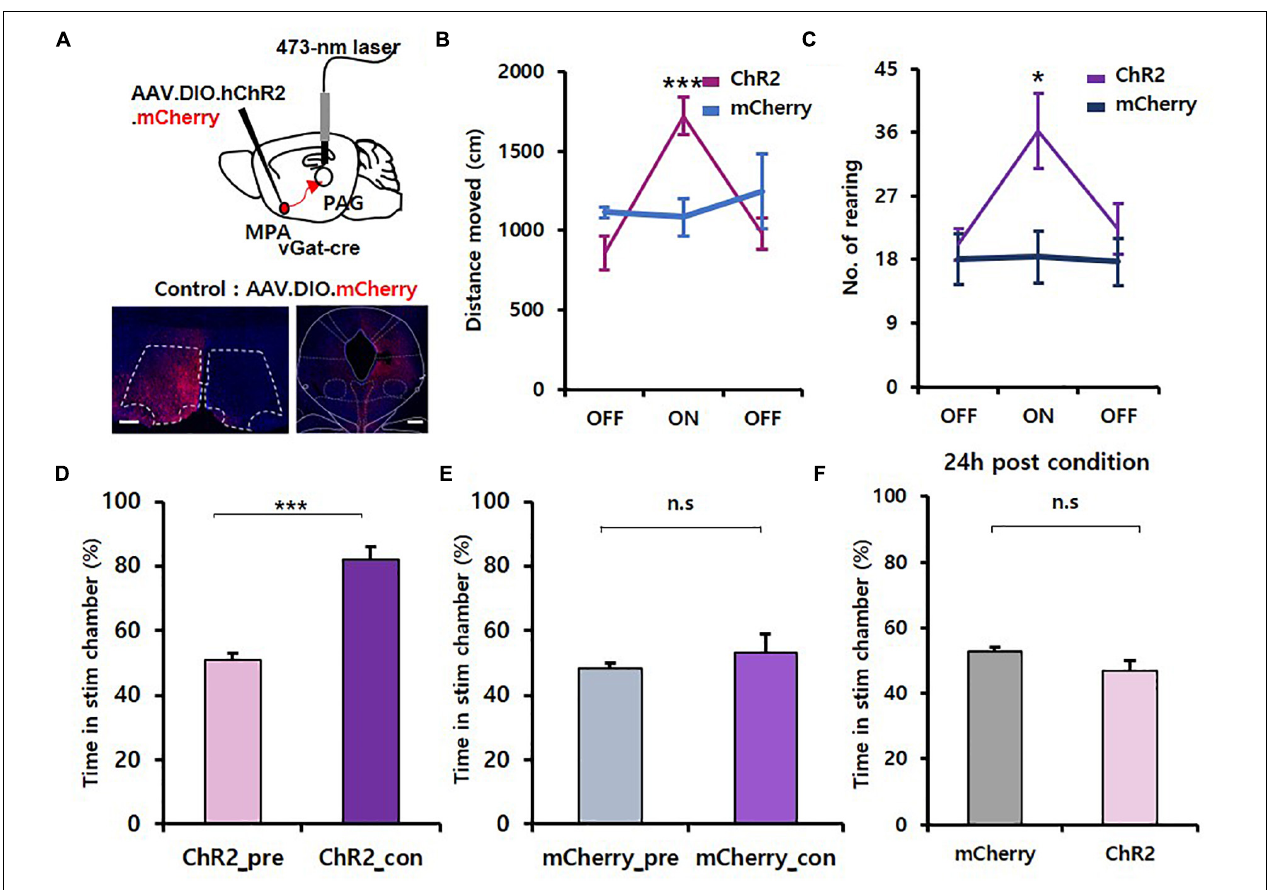
FIGURE 3 | Activation of the MPA vgat –vPAG circuit induces exploration without encoding value. (A) Top, MPA–vPAG circuit photostimulation. Viruses were injected into the MPA, and fiber-optic cannulas were implanted over the vPAG. Bottom, virally mediated expression of ChR2 in MPA neurons of vgat -ires- Cre mice and axon termini in the vPAG. Scale bar, 250 µ m. (B) Photoactivation of MPA vgat neuron axon termini causes increased movement in ChR2-expressing mice ( n = 7; n = 4 males; n = 3 females) compared to mCherry control mice ( n = 3; n = 1 male; n = 2 females); *** p < 0.001. Error bars represent SD. (C) Number of rearing significantly increases in ChR2-expressing mice ( n = 7; n = 4 male; n = 3 females) compared to mCherry control mice ( n = 3; n = 1 male; n = 2 females); * p < 0.05. Error bars represent SD. (D) ChR2-expressing ( n = 7; n = 4 males; n = 3 females) mice show more time in the stimulation chamber during the conditioning session compared to the pretest session; *** p < 0.001. Error bars represent SD. (E) mCherry control ( n = 3; n = 1 male; n = 2 females) do not show real-time preference toward the stim chamber; p = 0.562. Error bars represent SD. (F) Testing for conditioned place preference 24 h after the conditioning session. mCherry control ( n = 3; n = 1 male; n = 2 females) and ChR2-expressing ( n = 7; n = 4 males; n = 3 females) mice do not show preference toward the stim chamber; p = 0.270. Error bars represent